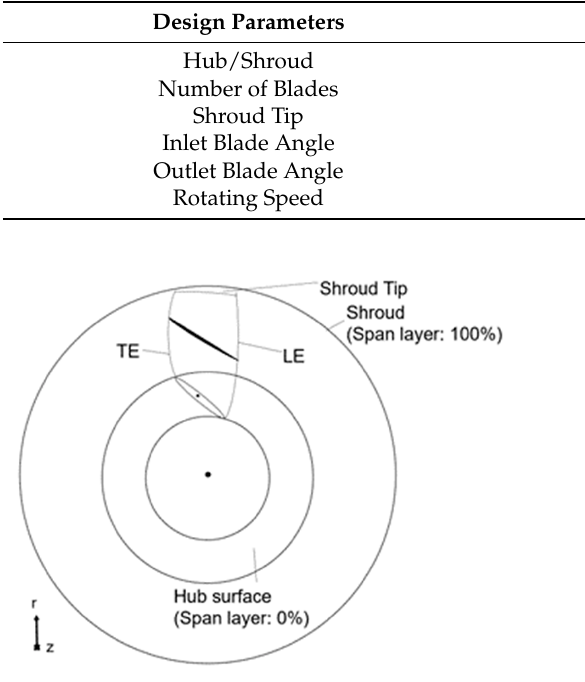
Figure 3. Front view of the three-dimensional blade.